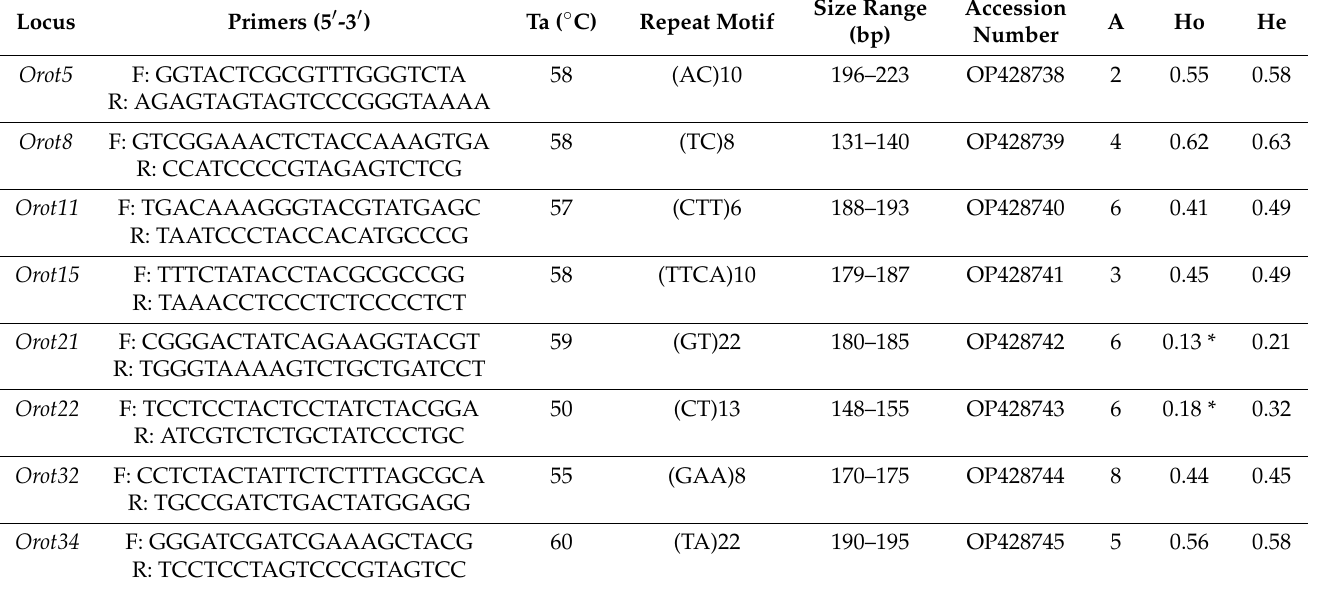
Table 1. Characteristics and genetic diversity statistics of the nuclear microsatellite markers used in the genetic study of Ocotea rotundata . For each locus, the mean number of alleles (A), mean expected heterozygosity (He), and the mean observed heterozygosity (Ho) are shown. * indicates a significant departure from